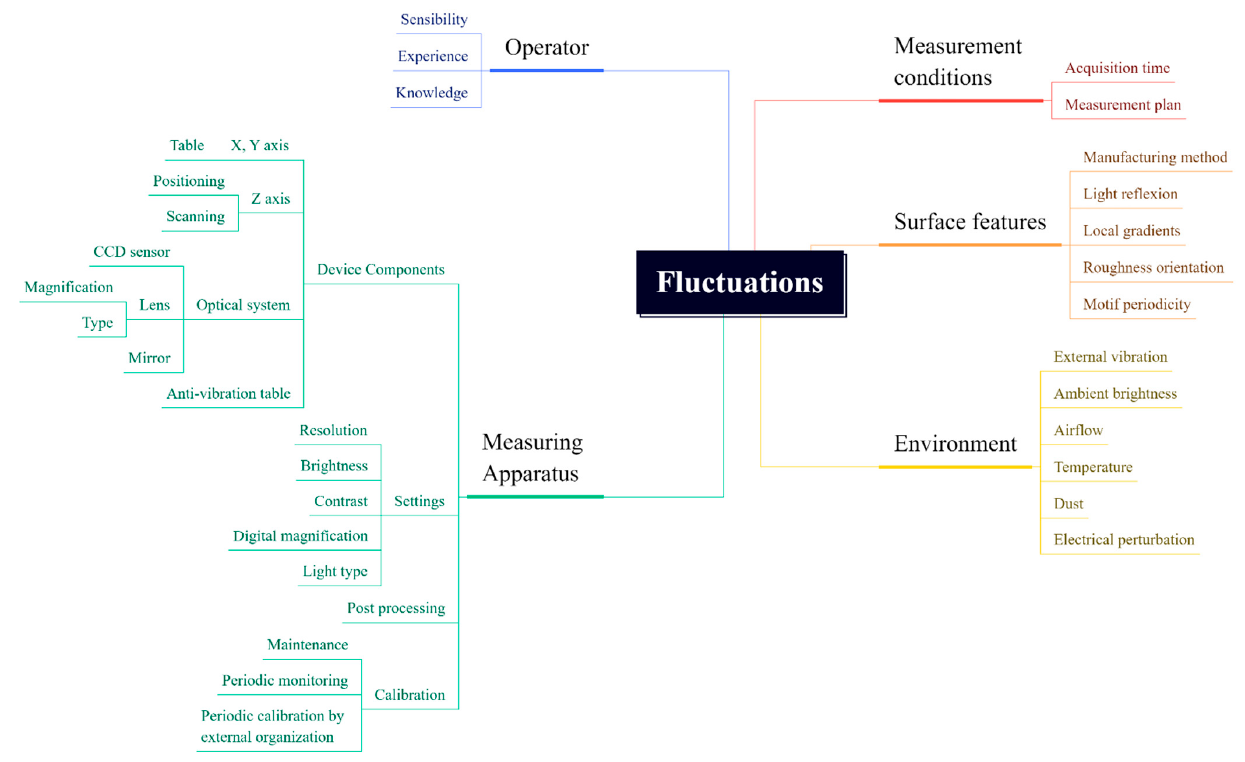
Figure 1. Sources of topographical fluctuations.